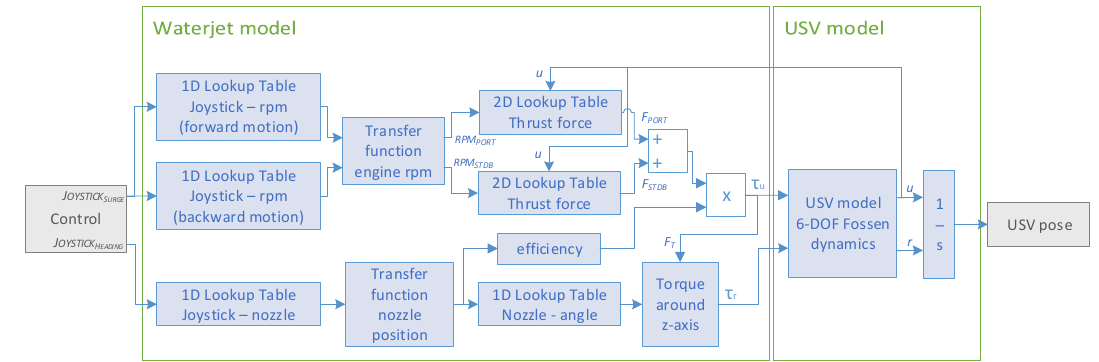
Figure 4. Schematic of the mathematical model of the USV including both waterjet propulsion system and USV dynamic models.